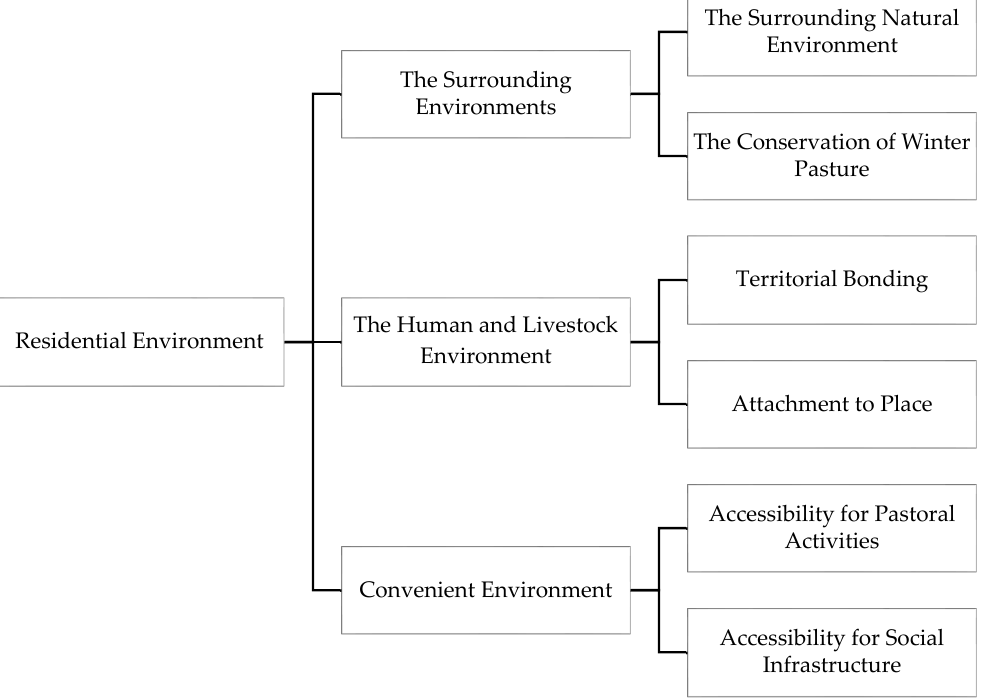
Figure 8. Residential environment index system in rural Mongolia.